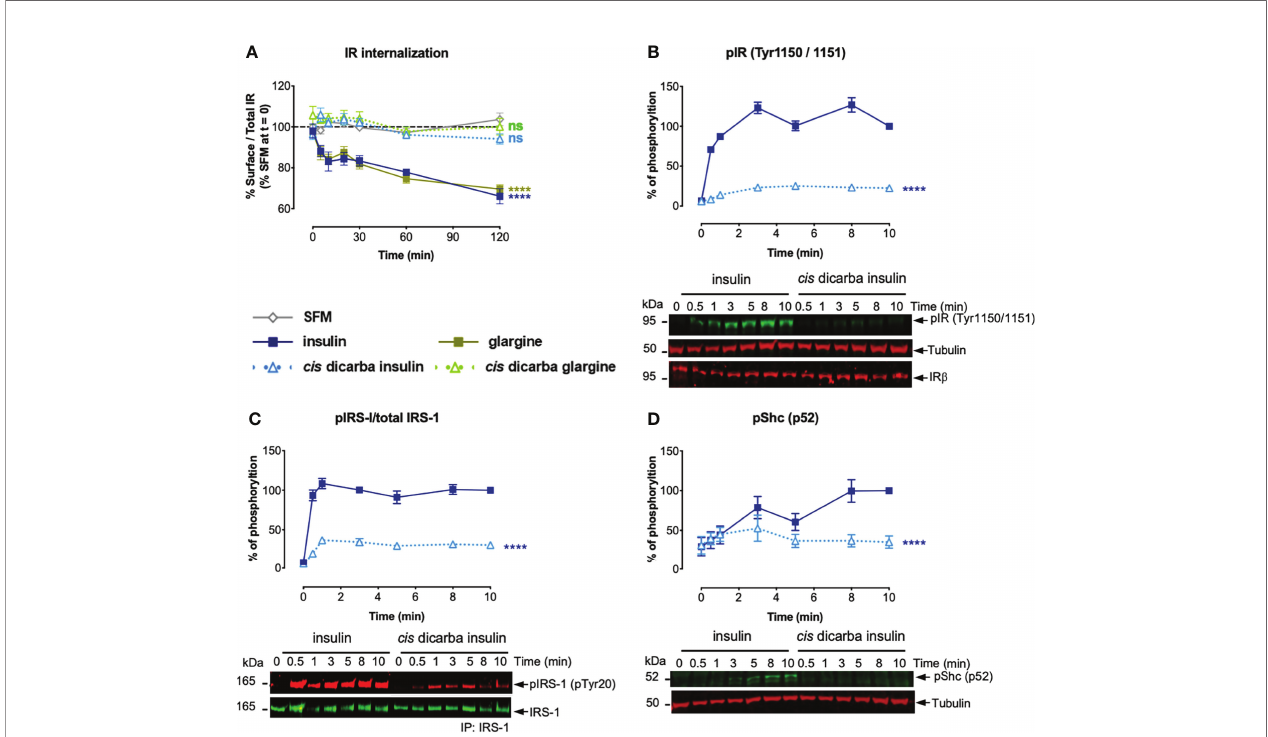
FIGURE 6 | Cis- dicarba analogues are incapable of promoting IR-A internalization due to inability to promote phosphorylation of IR-A, IRS-1 and Shc. (A) Serum starved IR-A overexpressing L6 myoblasts were treated with serum-free media (SFM; non-stimulated condition, grey) or 10 nM of insulin analogues in a time-course of t = 0, 5, 10, 20, 30, 60 and 120 min. Data are presented as % of surface receptor/total receptor followed by normalisation with % of surface receptor in SFM at t = 0; i.e. SFM at t = 0 is equivalent to 100%. (B, C) Serum starved IR-A overexpressing L6 myoblasts (hIR-A L6) were stimulated with 10 nM of insulin or cis- dicarba insulin in a time-course of t = 0, 0.5 (30 s), 1, 3, 5, 8 and 10 min. Phosphorylation levels are expressed as percentage of level detected when cells were stimulated with 10 nM of insulin for 10 min: (B) IR (phospho-Tyr1150/Tyr1151); normalized to b -tubulin, IR b for loading control C) immunoprecipitated (IP) IRS-1 (pTyr20: total tyrosine phosphorylation); normalized to total IRS-1 and (D) p52 Shc (phospho-Tyr239/Tyr240); normalized to b -tubulin. All data are the mean ± S.E.M. n = at least 3 independent experiments. Error bars are shown when greater than the size of the symbols. Statistical signi fi cance were determined via one-way repeated measures ANOVA followed by Dunnets multiple test. For receptor internalization (A) , statistical analyses were performed comparing the effect of insulin analogues and SFM. For (B-D) , statistical analyses were performed comparing insulin and cis- dicarba insulin. ns: non-signi fi cant; **** (P ≤